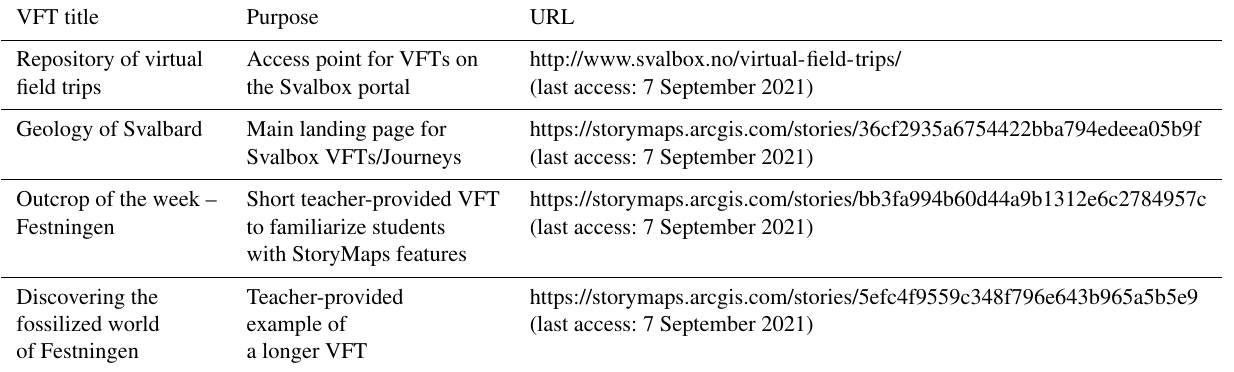
Table 5. Examples of virtual field trips (VFTs) available on